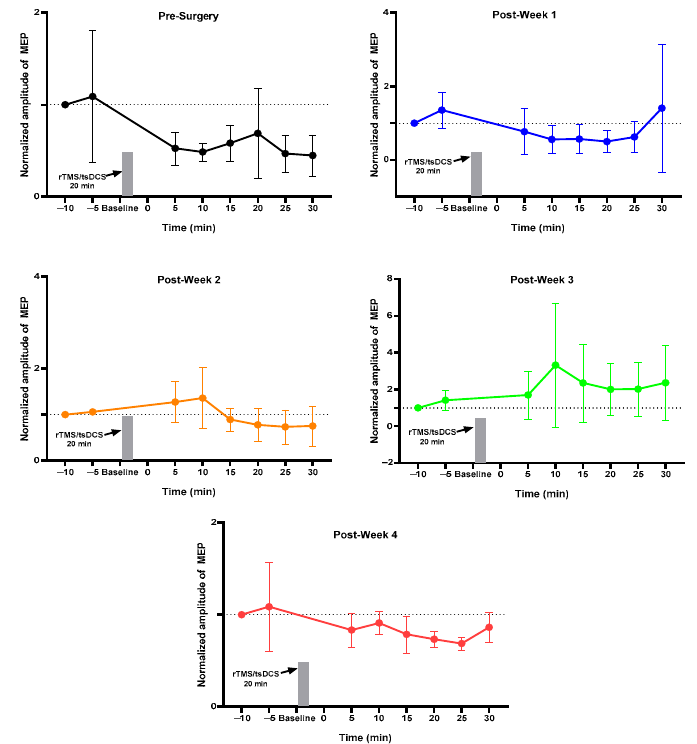
Figure 5. rTMS/tsDCS ( n = 3). rTMS/tsDCS (20 min).